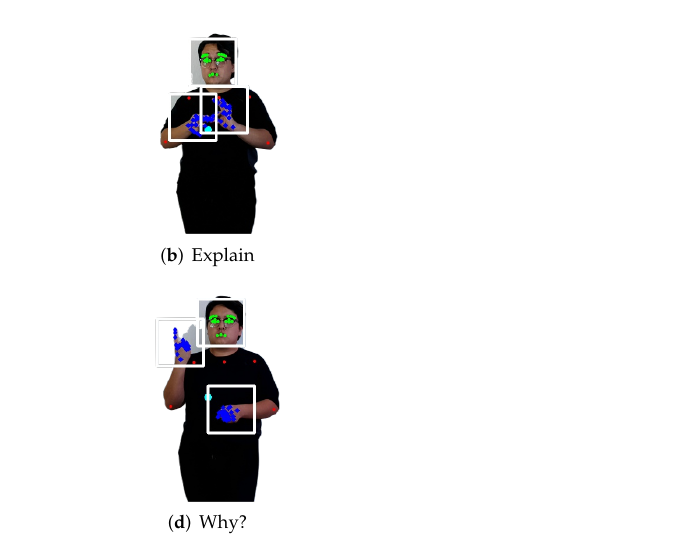
Figure 4. Recurrent neural network architectures.